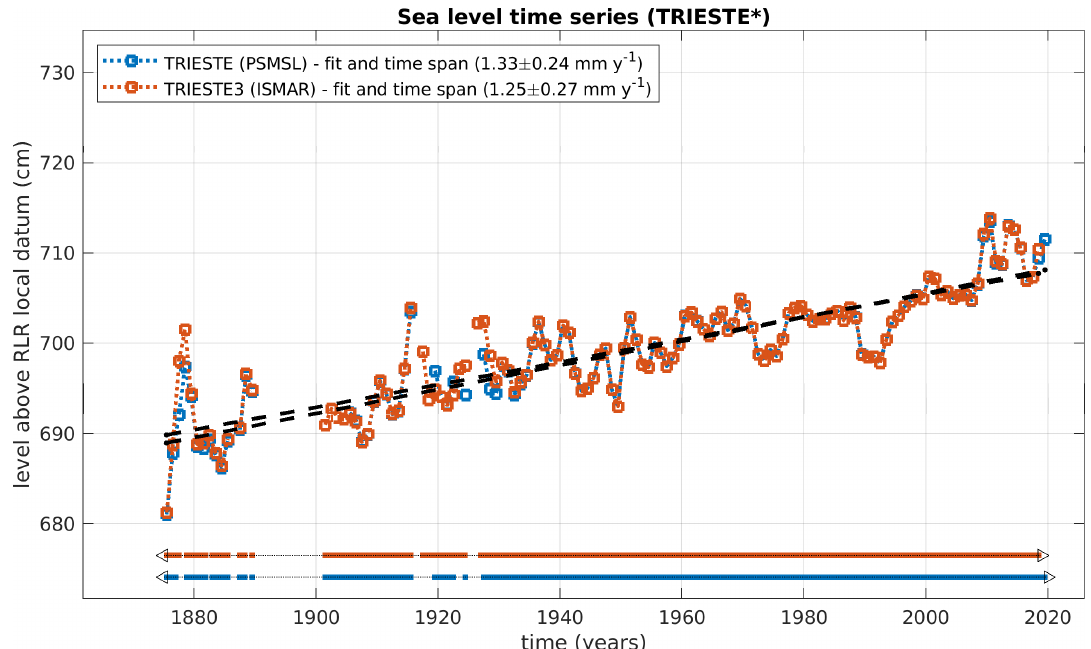
Figure 4. Same display as in previous figure for two time series of SL available in Trieste Molo Sartorio. TRIESTE record is available from Permanent Service for Mean Sea Level (PSMSL), and TRIESTE3 record, based on the same raw SL data as TRIESTE, was kindly provided by Fabio Raicich, CNR-ISMAR.